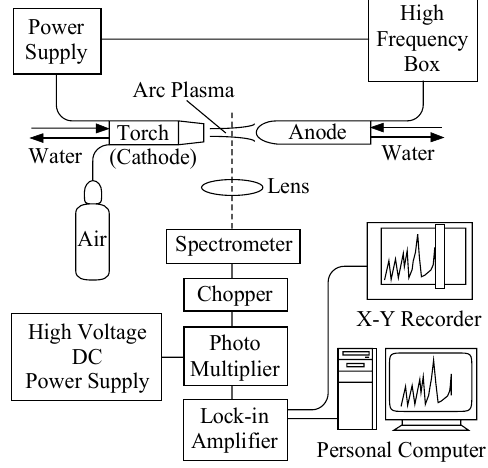
Fig. 7 Schematic of experimental